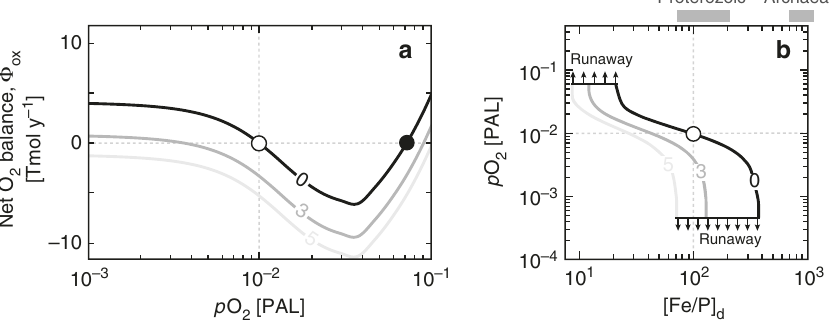
Fig. 6 Representative results from our global ocean-sediment biogeochemical model (CANOPS-KB). a Each curve shows net oxygen fl uxes ( Φ ox ) as a function of atmospheric p O 2 . Intersection points at Φ ox = 0 indicate regions of parameter space in which the O 2 cycle is at equilibrium and dominated by negative feedback (negative slope) and positive feedback (positive slope). Circles plotted along the black curve thus show examples of stable (open) and unstable (closed) equilibrium points for model runs at a nominal deep ocean Fe/P ratio of 100. Each curve is labeled by an assumed external reductant fl ux (i.e., volcanic/metamorphic reductant input minus O 2 accumulation due to hydrogen escape and/or imbalances in global S and Fe cycling, Φ red ) in Tmol O 2 equivalents year − 1 . b Each curve plots stable equilibrium p O 2 values as a function of deep ocean Fe/P ratio ([Fe/P] d ) under the same conditions as shown in a . The ( ○ ) shows our nominal model ([Fe/P] d = 100 and no external reductant input). Arrows above and below the curves denote regions where our model predicts runaway oxygenation or deoxygenation, respectively. Also shown in b are approximate estimates of [Fe/P] d for the Archean and Proterozoic (shaded gray bars; see